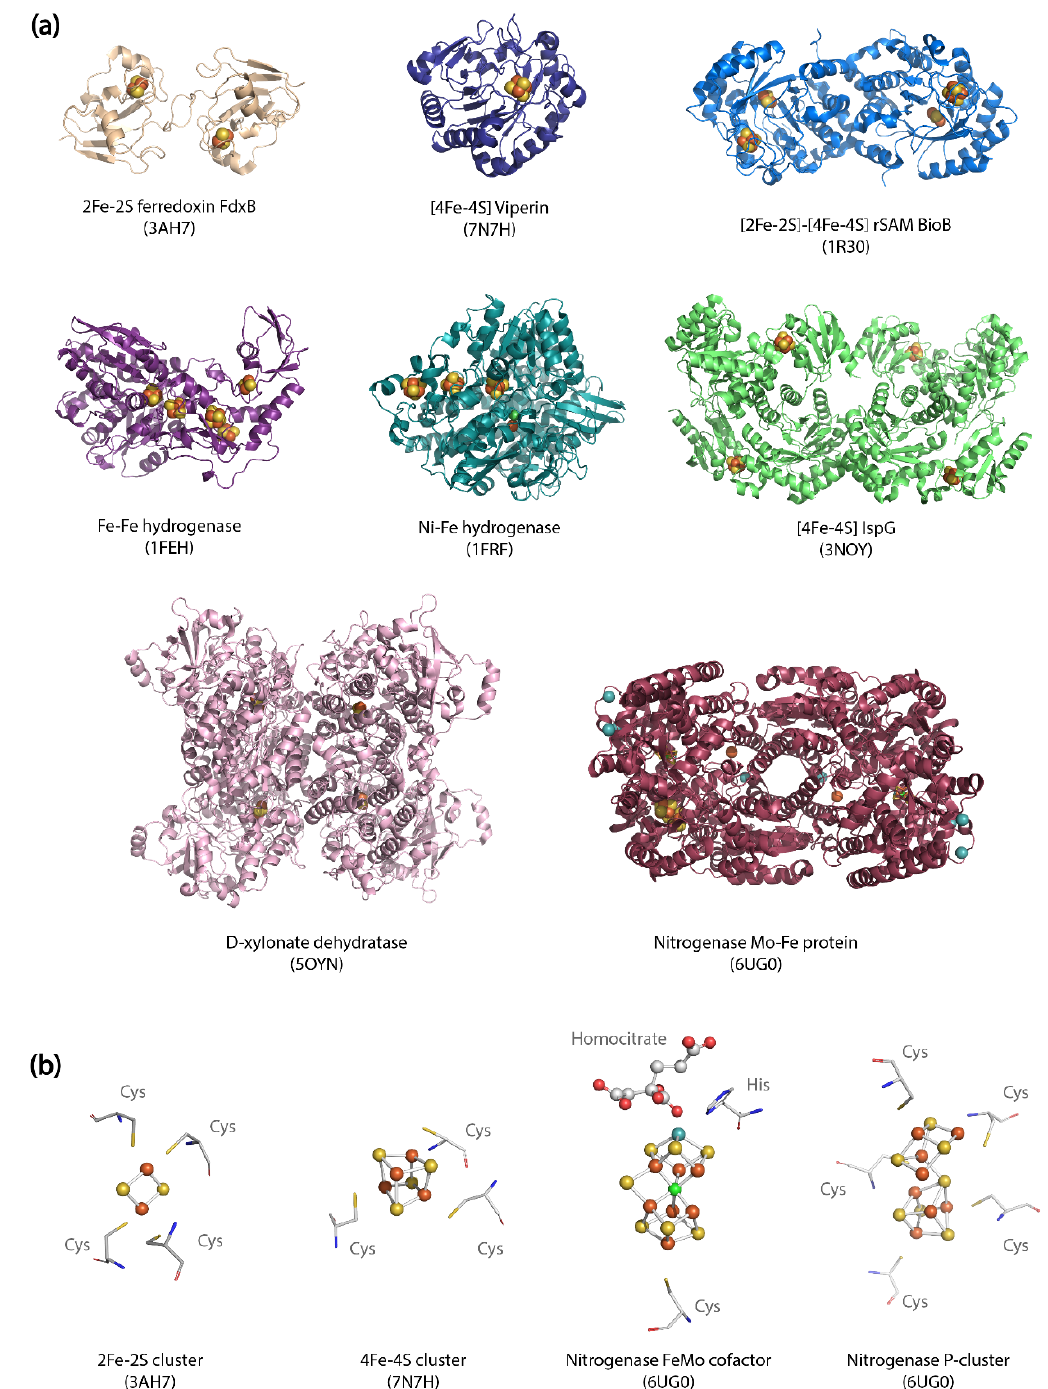
Figure 1. Structural diversity of metallocluster enzymes. ( a ) Crystal structures of diverse metallocluster enzymes bound to their metal cofactors. PDB entries and origin of each protein structures are listed in Appendix A Table A1. ( b ) Structure and environment of different metalloclusters from biotechnologically relevant enzymes.